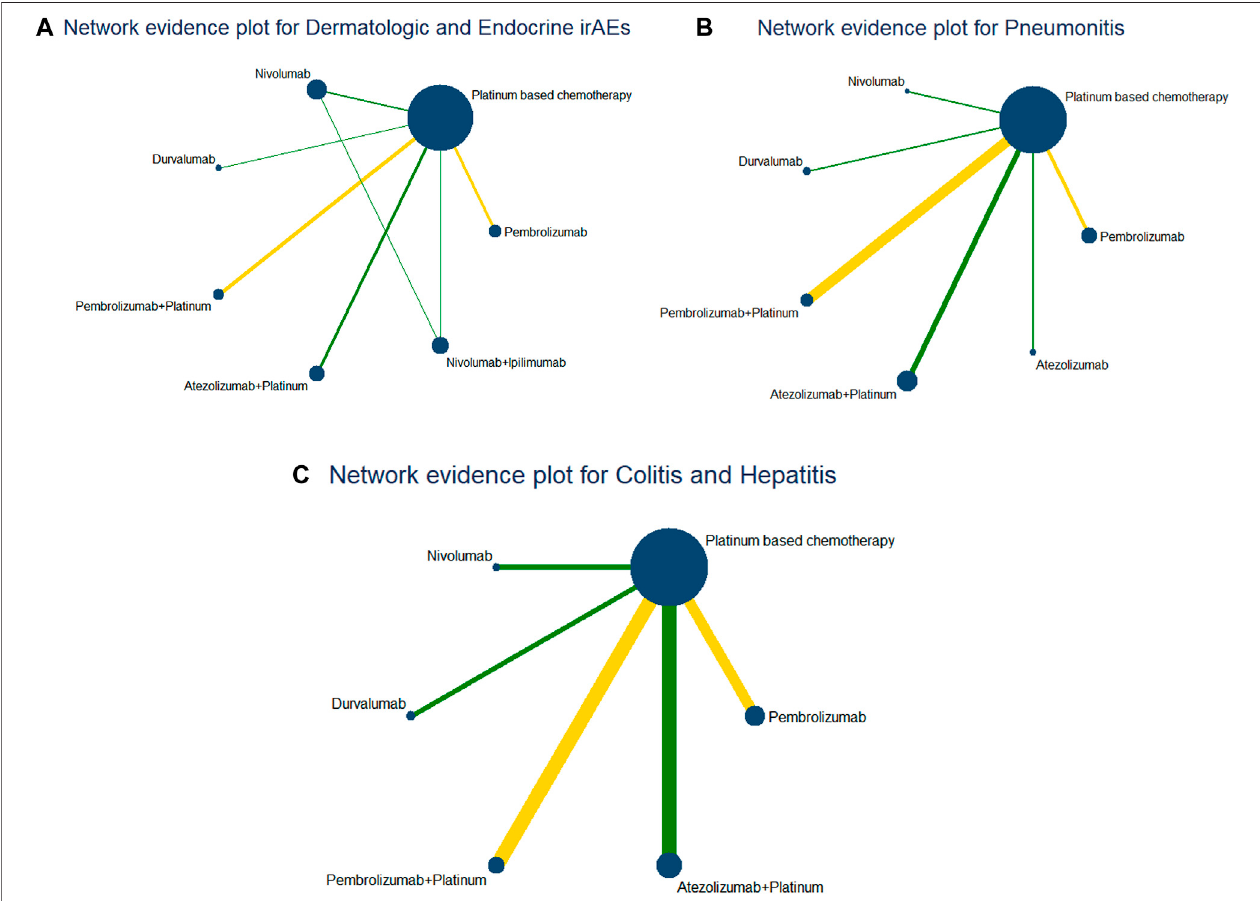
FIGURE 3 | Network diagrams of comparisons on all outcomes in this network meta-analysis. (A) Comparisons on dermatologic and endocrine irAEs in patients with advanced NSCLC. (B) Comparisons on pneumonitis in patients with advanced NSCLC. (C) Comparisons on colitis and hepatitis in patients with advanced NSCLC.(The circles represent treatment regimens and the size of each circle represents the number of participants, while the yellow line represents double-blind RCTs and the green is not blind.)